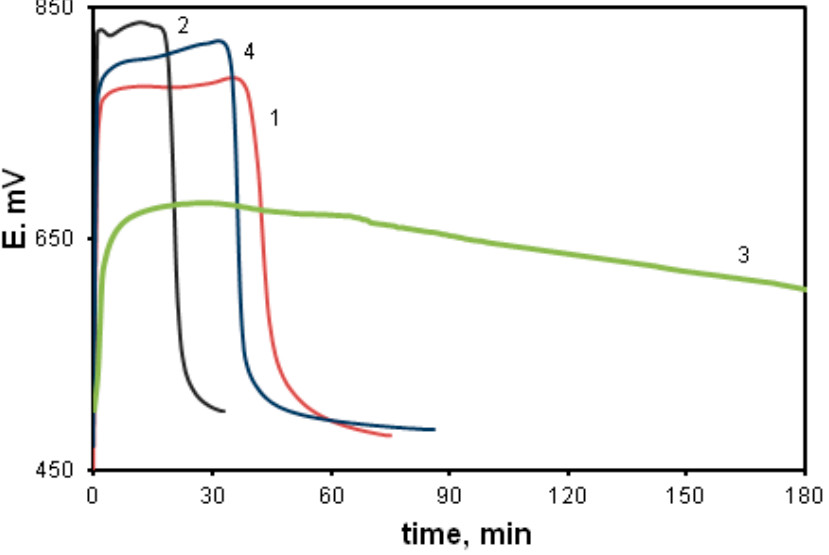
Figure 12. Time dependence of the redox potential during the oxidation of ASADCB (1), DADCB (2) and MADCB (3) at [HCl] = 0.5 mol/L, and ASADCB (4) at [HCl] = 1 mol/L. (2) and MADCB (3) at [HCl] = 0.5 mol/L, and ASADCB (4) at [HCl] = 1